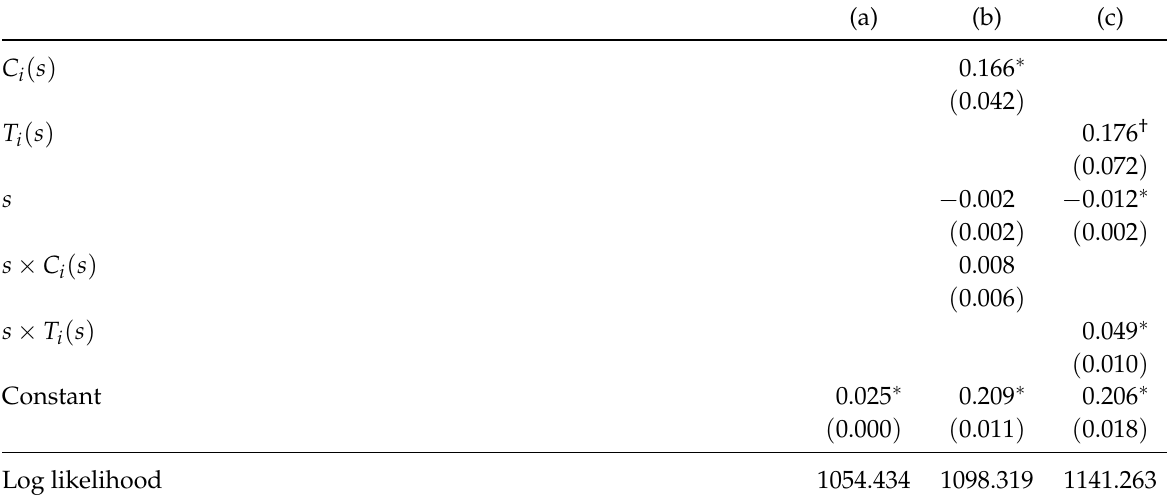
Table 3: Prediction of an individual’s C centrality and time-averaged cumulative centrality T i ( s ) = 1 errors are in